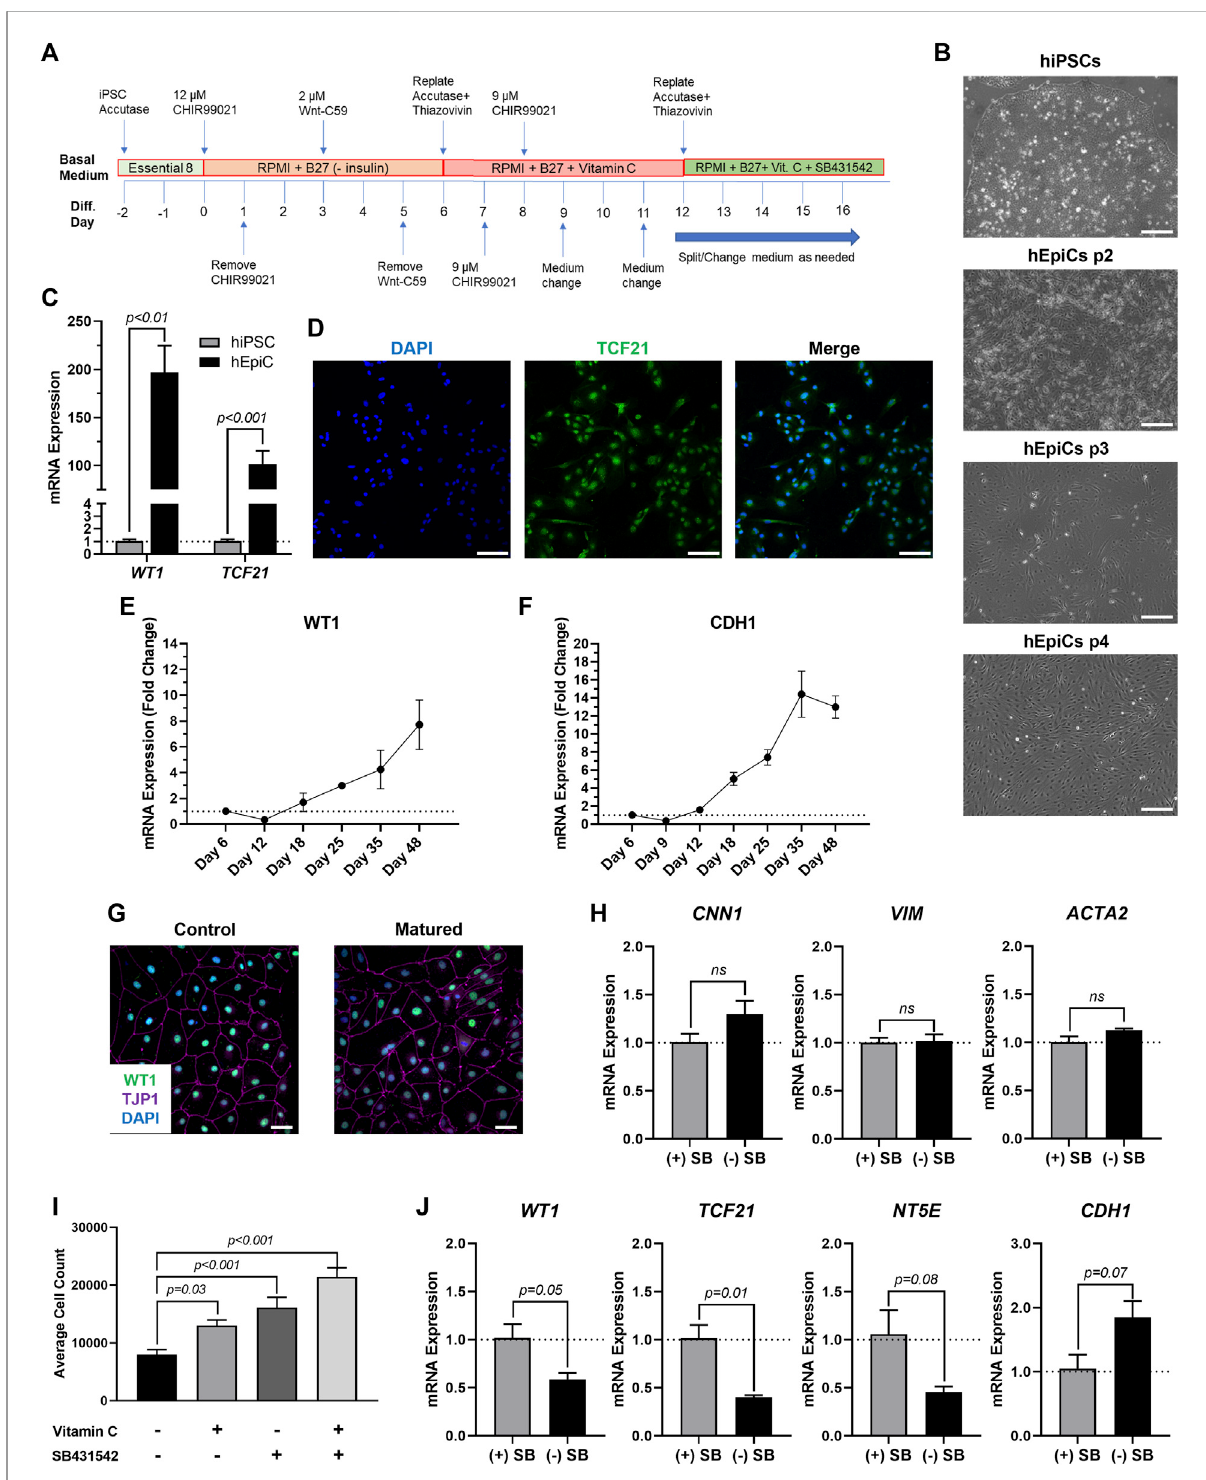
FIGURE 1 Differentiation of Mature-Like Epicardial Cell Cultures from hiPSCs. (A) Schematic of protocol used for hEpiC differentiation. (B) Bright fi eld imagesofhEpiCsthroughfourpassagesshowingthegradualaccumulationoftheclassicepithelialcellcobblestonemorphology;scalebar:500 µm. (C) qRT-PCR data for epicardial markers WT1 and TCF21 in hiPSCs and hEpiCs; n = 4-6 per cell line. (D) Confocal immuno fl uorescent images for TCF21 (green)andDAPI(blue)showingnearly 100%epicardialdifferentiation ef fi ciencyfrom hiPSCs;scale bar:100 µm. (E,F) TimecourseqRT- PCR data for WT1 (E) and CDH1 (F) throughout hEpiC differentiation, suggesting an increase in epicardial nature over time; n = 3 per time point. (G)